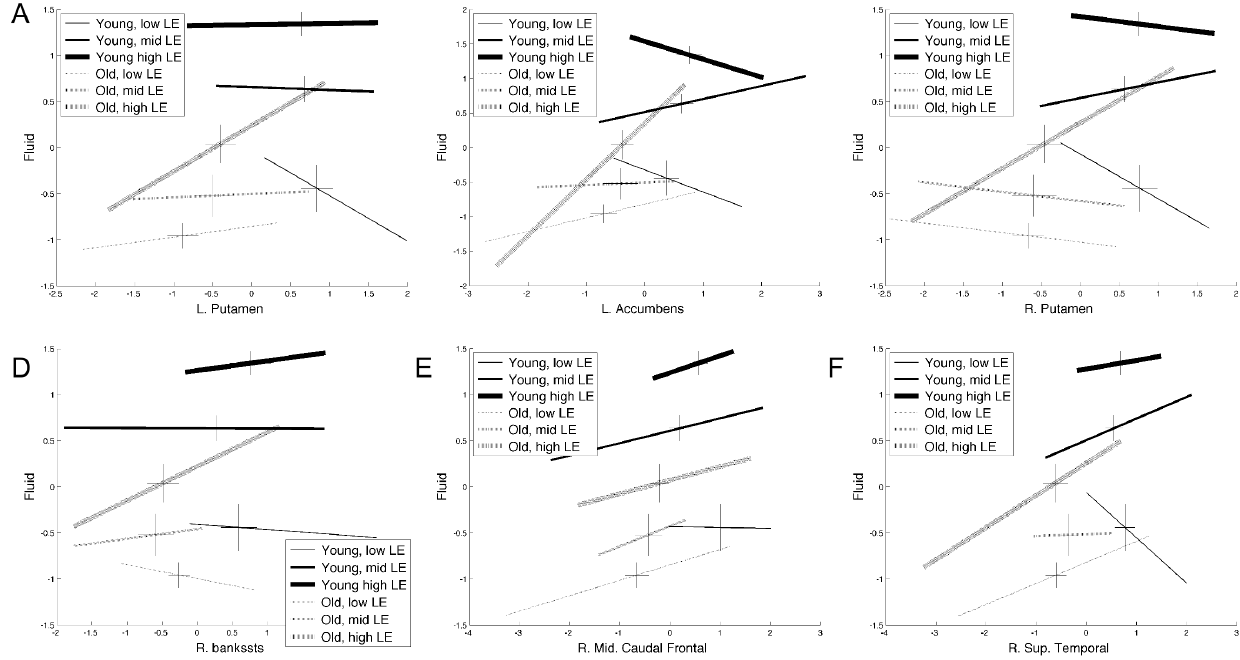
Figure 4. Diagram explaining results by comparing brain measures to cognitive measures for both age groups and various levels of lifetime exposures (LE). This diagram uses results from Model B and the left accumbens volume from Figure 3B as a guide. Parameters refer to those from equations and models in Figure 1. A) Parameter a represents a difference between age groups for the brain measure. Parameter c’ represents a difference between age groups for the cognitive measure. B) The crosses plot the brain and cognitive measures against each other for three levels of LE for both age groups. The parameter q represents the differing relationship between the brain and cognitive measures for the three different LE groups, low middle and high. C) The parameter b represents the overall relationship between the brain and cognitive measures across all levels of LE, i.e. the slope. D) The parameter v represents the differing relationship between the brain and cognitive measures for the three LE groups.